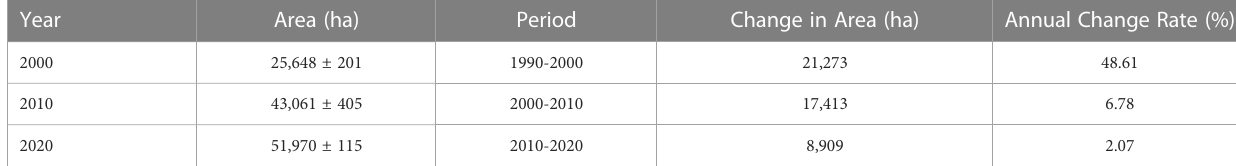
TABLE 2 Areas and changes in S. alterni fl ora invasion over the last two decades in China ’ s coastalines and